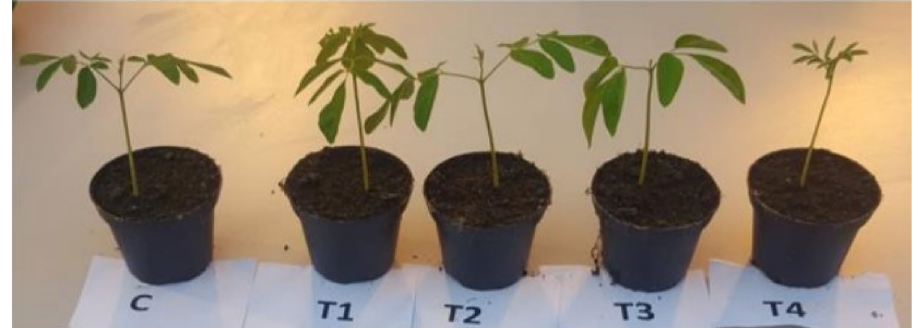
Figure 5. Seedlings of M. oleifera emerged from H 2 O 2 soaked seeds treated with atmospheric pressure cold plasma for 10 min at doses of 2.46 mJ (T1), 4.35 mJ (T2), 10.94 mJ (T3), and 18.51 mJ (T4) compared to seedlings emerged from untreated non-H 2 O 2 soaked seed (C).